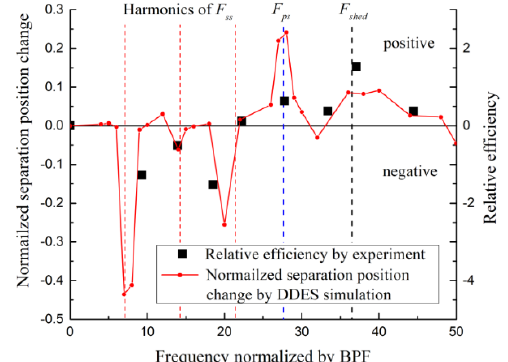
Figure 13. E ff ect of unsteady excitation at near stall Figure 13. Effect of unsteady excitation at near stall point.